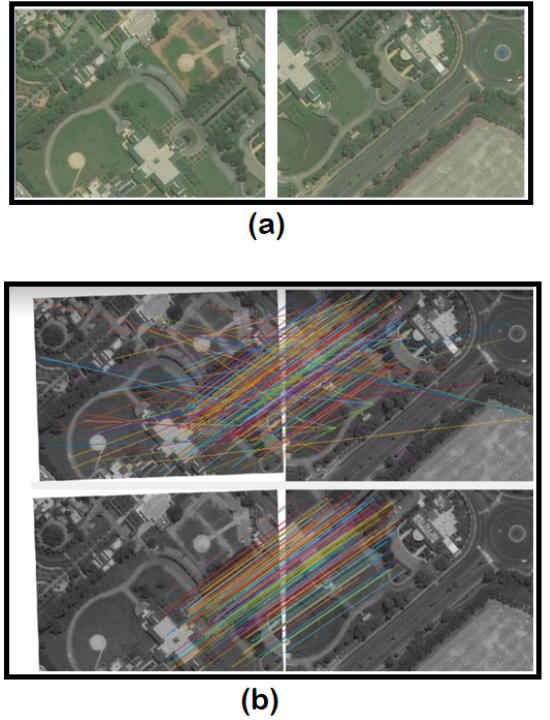
Figure 3. Demonstration of process in sample area: ( a ) true color RGB image of the adjacent tiles. ( b ) Illustration of identified collinear points from SIFT feature points in adjacent tiles using RANSAC